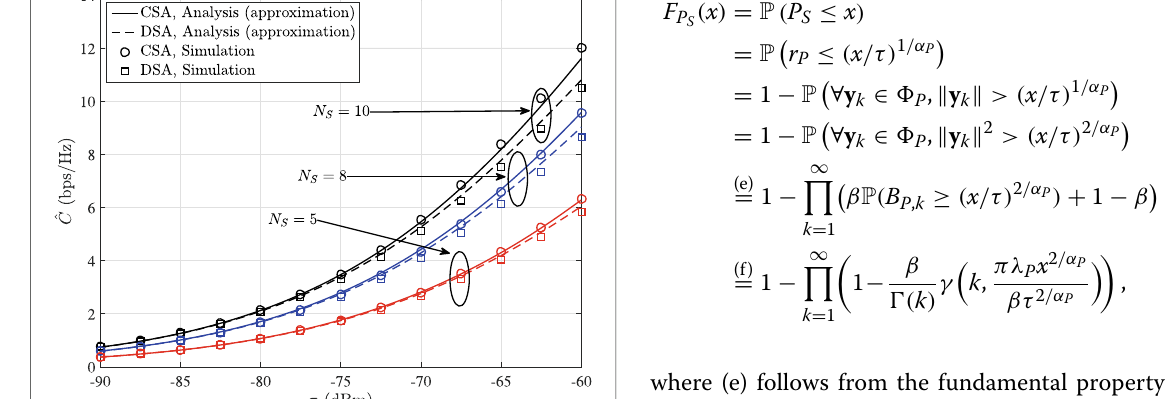
Fig. 6 The total average SU achievable rate ˆ C as a function of τ when the spatial distribution of PBSs follows a β -GPP ( β = 1)